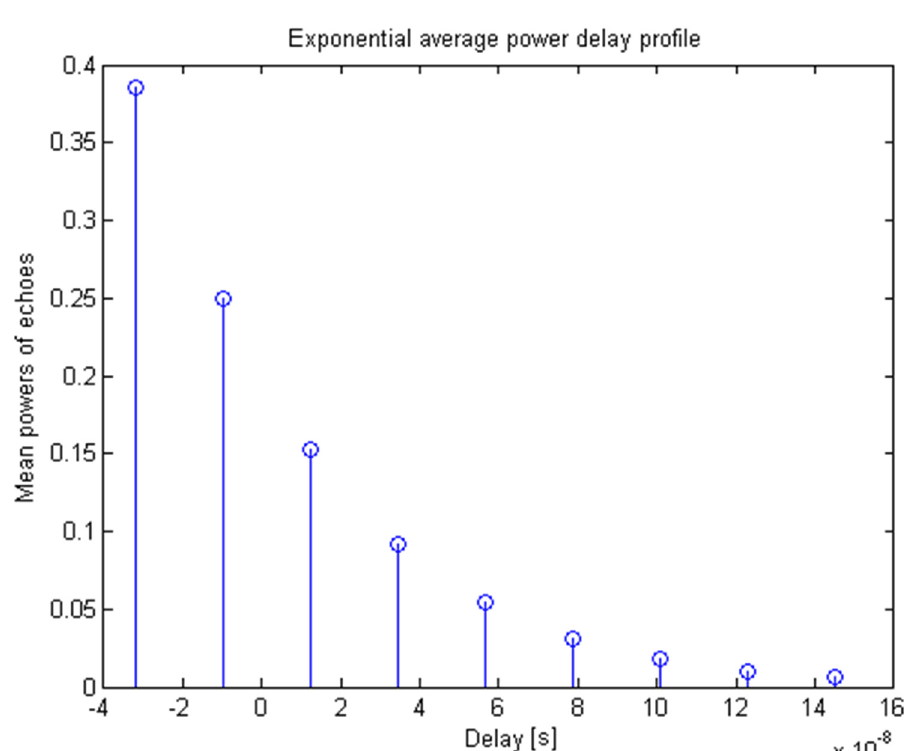
Figure 5. Exponential profile; rms delay spread σ τ = 2 T S ; T S = 76